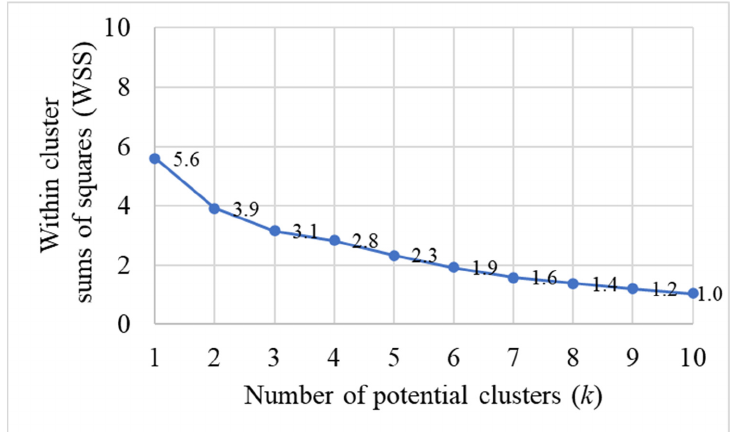
Figure 3. Graph of within-cluster sums of squares (WSS) versus number of potential clusters ( k ).